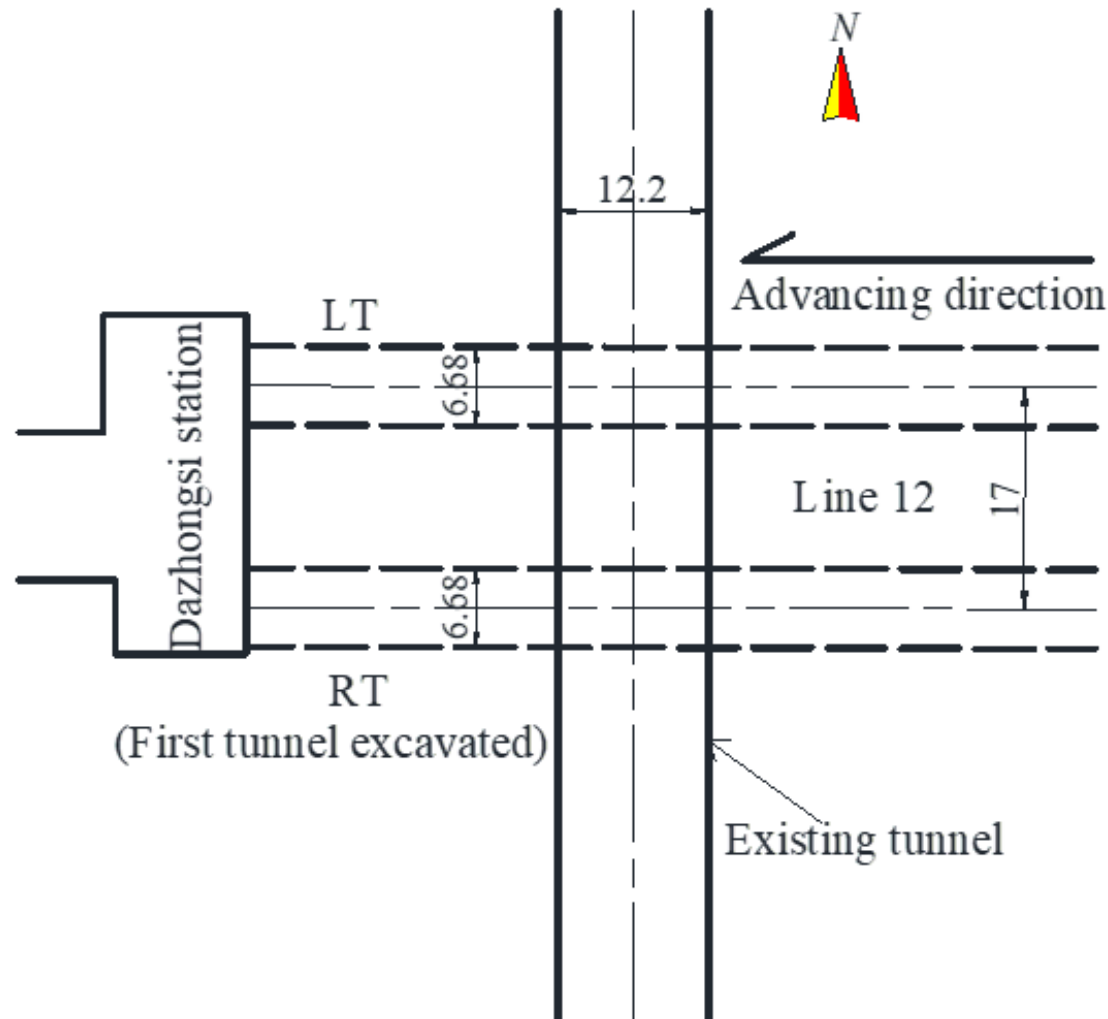
Figure 2. Diagram of existing and new tunnels (unit: m).